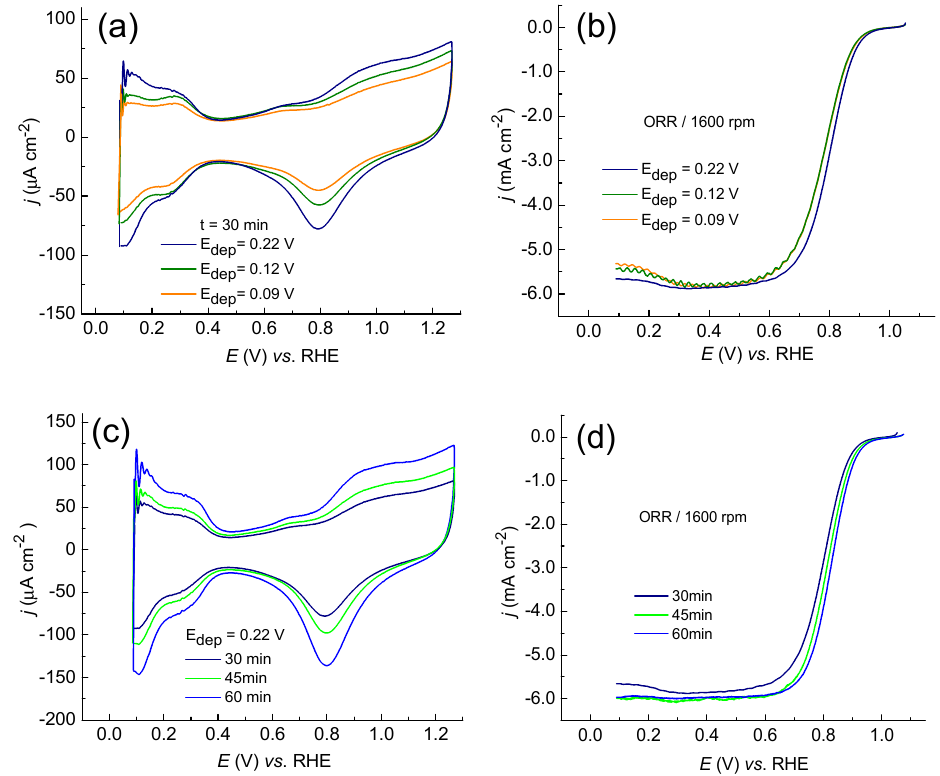
Figure 2. Electrochemical characterization of different Pt/GC electrodes in 0.1 M HClO 4 : ( a ) CVs of Pt/GC prepared by Pt deposition for 30 min at different applied potentials, and ( b ) corresponding ORR polarization curves. ( c ) CVs of Pt/GC prepared by Pt deposition at 0.22 V for different times and ( d ) corresponding ORR polarization curves. CVs were recorded from deaerated and ORR polarization curves in oxygen-saturated solution at a scan rate of 50 mV s − 1 .